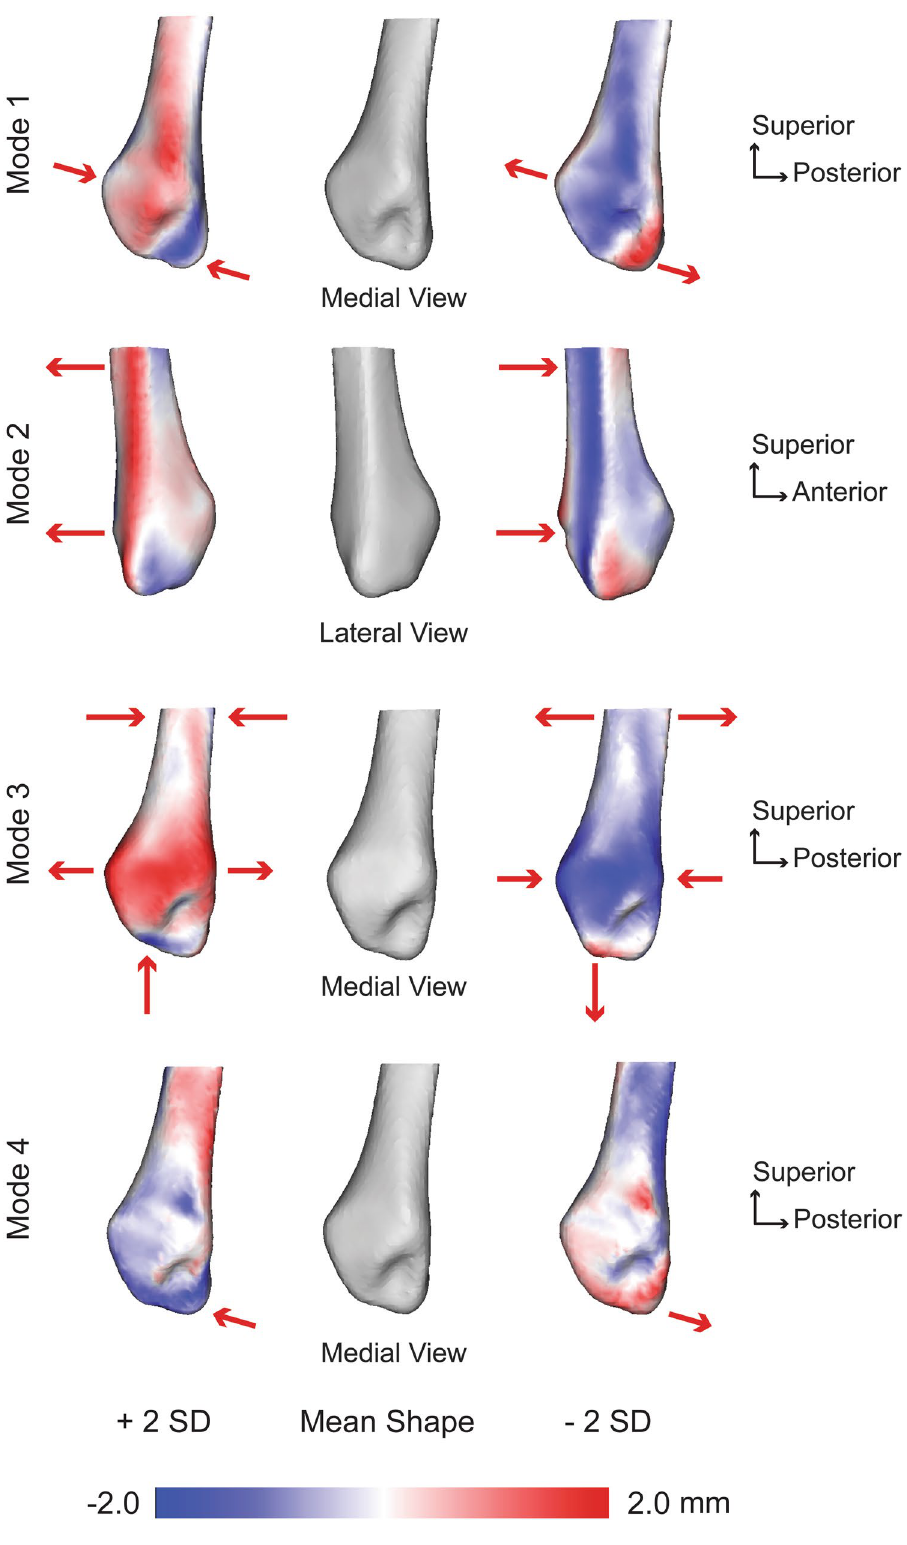
Figure 2. Fibular modes of variation 1–4 showing significant anatomical differences observed at ± 2 standard deviations (SD) from the mean shape (center; grey). Red arrows focus on the location and direction of change for key anatomical features (pointing at the bone indicates the decreased size of a feature, whereas an arrow pointing away from the bone indicates an increased size of a feature). Surface distances shown on ± 2 SD represent the distance away from the mean shape with a scale in millimeters